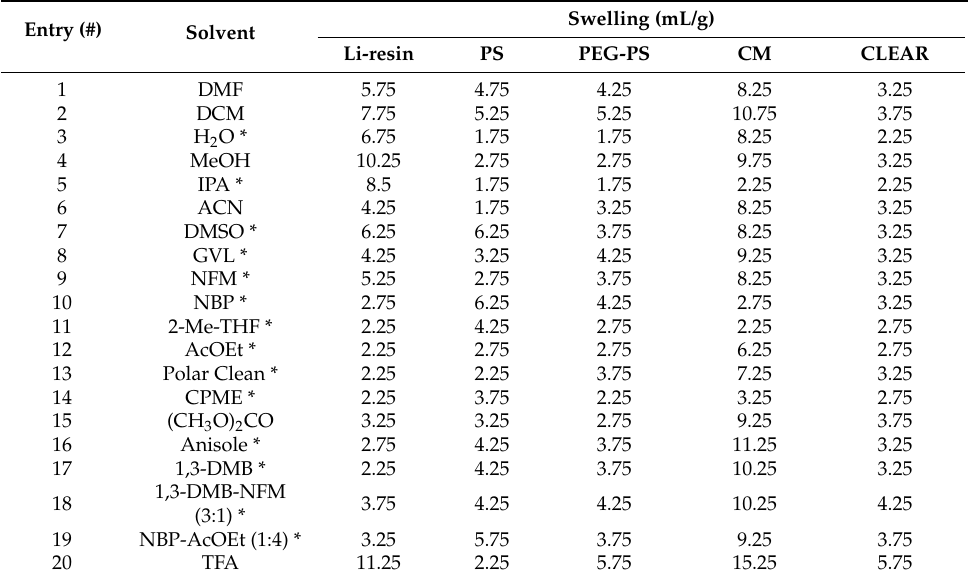
Table 1. Swelling of the selected resins in green and non-green solvents.